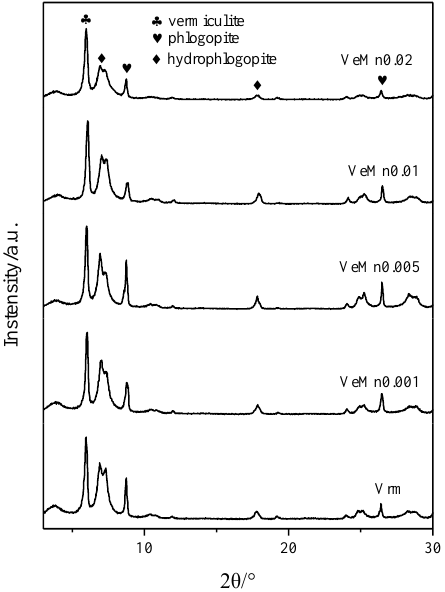
Figure 3. Effect of manganese dioxide on crystal structure.